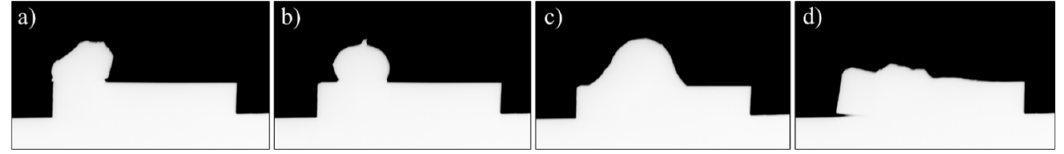
Figure 2. Drop profiles of Fe50 in contact with AgCuIn at ( a ) 0 s from the start of melting, ( b ) 100 s, ( c ) 600 s, and ( d ) 1200 s.